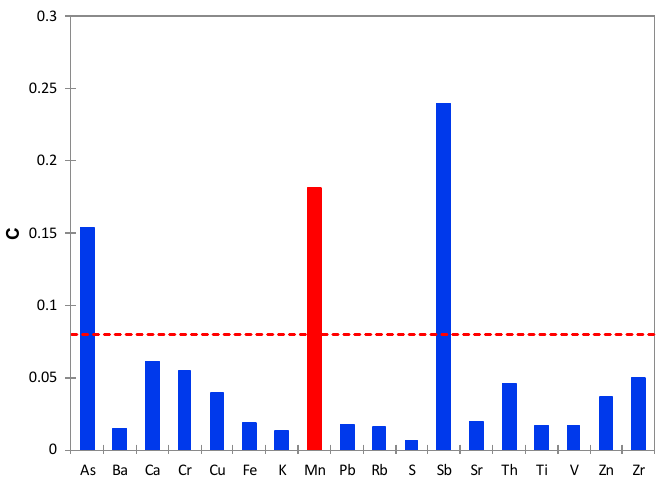
Table 2. Contribution of each element to the six main factors for B horizon observations, pXRF clr data.